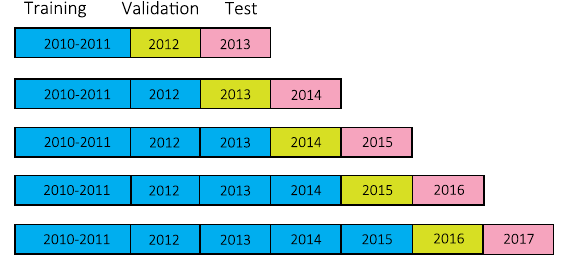
Fig. 4 Explanation of time-series CV. The series of training, validation, and test sets, where the blue observations form the training sets, the green observations form the validation sets, and the red observations form the test